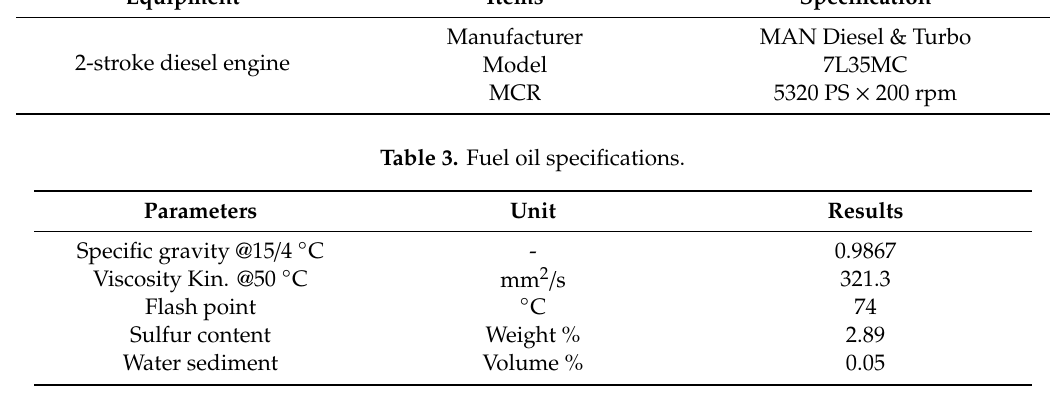
Table 3. Fuel oil specifications.